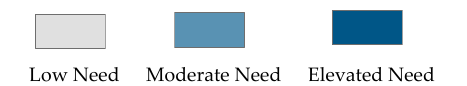
Figure 1. Domain composite need indices, in 67 counties in Pennsylvania.